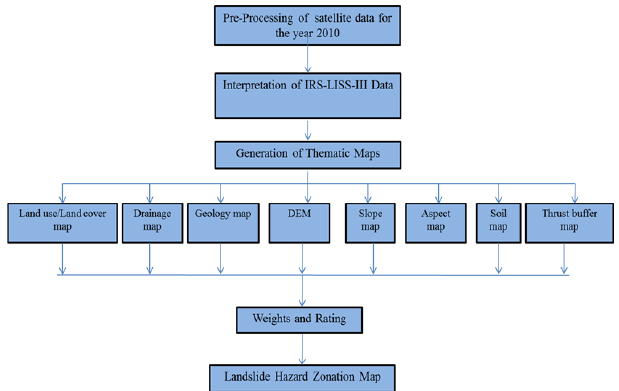
Figure 2. Methodology for preparation of Landslide Hazard Zonation map